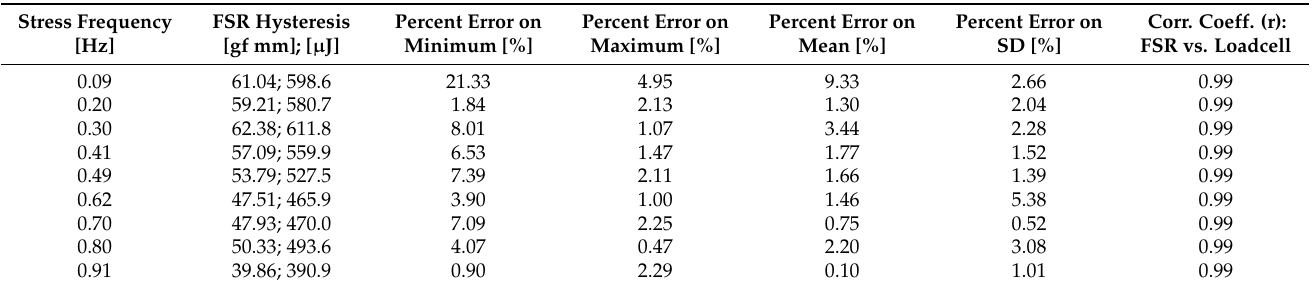
Table 3. Hysteresis of the FSR-based sensor, percent errors of the main descriptive statistics of measurements from FSR versus loadcell values, and correlation coefficients between the FSR and loadcell signals, computed for various stress frequencies.